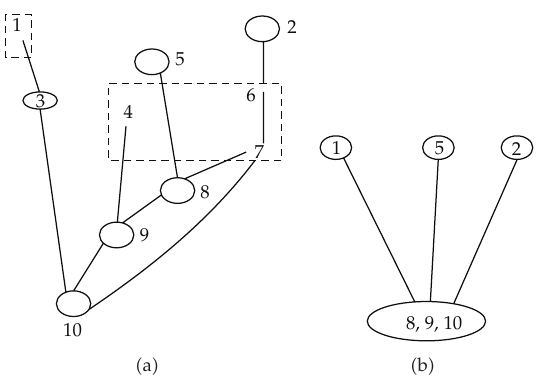
Figure 7: (cid:5) a (cid:6) P hm the S -Hypermoral Partition. (cid:5) b (cid:6) BN2 Representing P S S